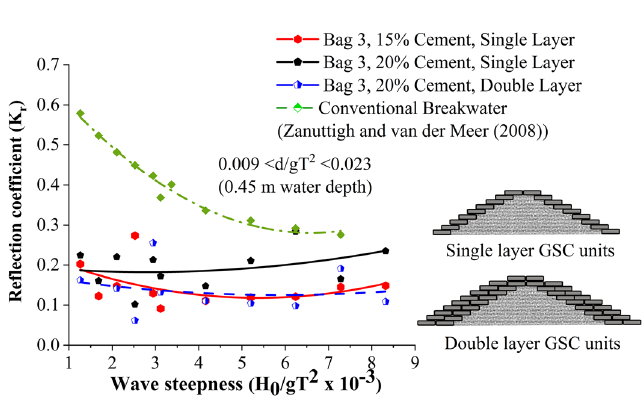
Figure 8. Calculated K r values for all the tested cases.